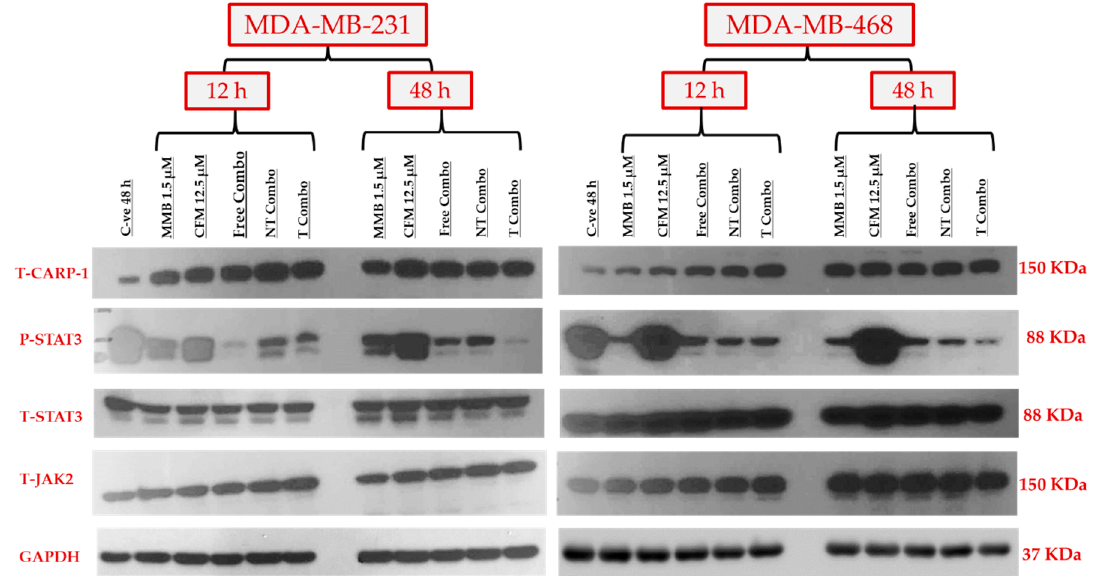
Figure 10. The molecular mechanism of the synergistic anticancer activity of MMB + CFM-4.16 combinations. Western blotting of the oncogenic P-STAT3, tumor suppressor CARP-1, T-STAT3, T-JAK2, and GAPDH for the individual drugs and MMB + CFM-4.16 combinations in both MDA-MB-231 and MDA-MB-468 at 12 and 48 h. MMB + CFM-4.16 combinations showed simultaneous downregulation of P-STAT3 and up-regulation of the CARP-1 compared to the control and individual drugs at both 12 and 48 h in both cell lines. The combinations, especially the T combo, were able to upregulate CARP-1 in the first 12 h compared to individual CFM-4.16 in both cell lines. The potency of NT combo and T combo was owing to their sustained release and prolonged effect on suppressing P-STAT3 both cell lines. Even the free combo was able to completely wipe out P-STAT3 in the first 12 h in MDA-MB-231, yet, the impact was short-term effect as there was little upregulation of P-STAT3 at 48 h unlike the NT and T combo which had stable and ascending cumulative effect. There was no change in the T-SAT3 and T-JAK2 in both cell lines. GAPDH was used as an internal control of protein loading. Note: T combo (CD44-T-PNPs+MMB), NT combo (NT-PNPs+MMB) and free combo (CFM-4.16 + MMB) where MMB means momelotinib. The densitometry and uncropped blots are shown in Figure S5.